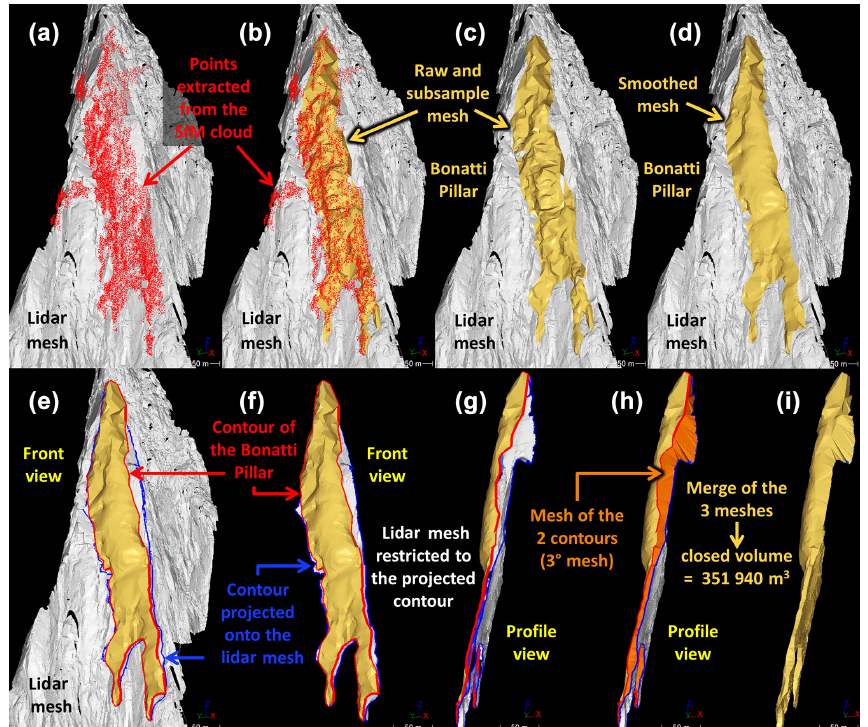
Figure 5. Volume calculation method. (a) Front view of the lidar mesh with the extracted SfM points highlighted in red in Fig. 4d and associated with the Bonatti Pillar collapse. (b) Same image as before but with the raw and subsample SfM mesh. (c) Front view of the lidar mesh with the raw and subsample SfM mesh. (d) Front view of the lidar mesh with the smoothed SfM mesh. (e) Same image as before but with the contour (in red) of the smoothed SfM mesh and the contour (in blue) orthogonally projected onto the lidar mesh. (f) Front view of the smoothed SfM mesh, its contour and the projected contour that allowed cutting the lidar mesh. (g) Profile view of the smoothed SfM mesh, its contour and the projected contour that allowed cutting the lidar mesh. (h) Same image as before but with the third mesh (in orange) that connects the two contours. (i) Profile view of the volume that collapsed between June 2005 and November